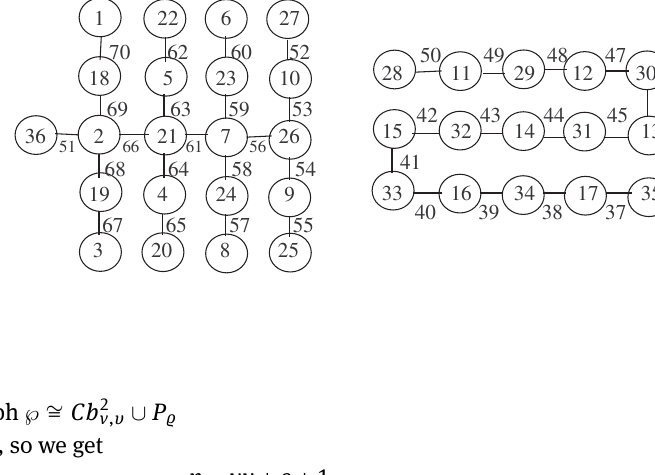
Figure 5: SEMT forest Cb 2 4,5 ∪ P